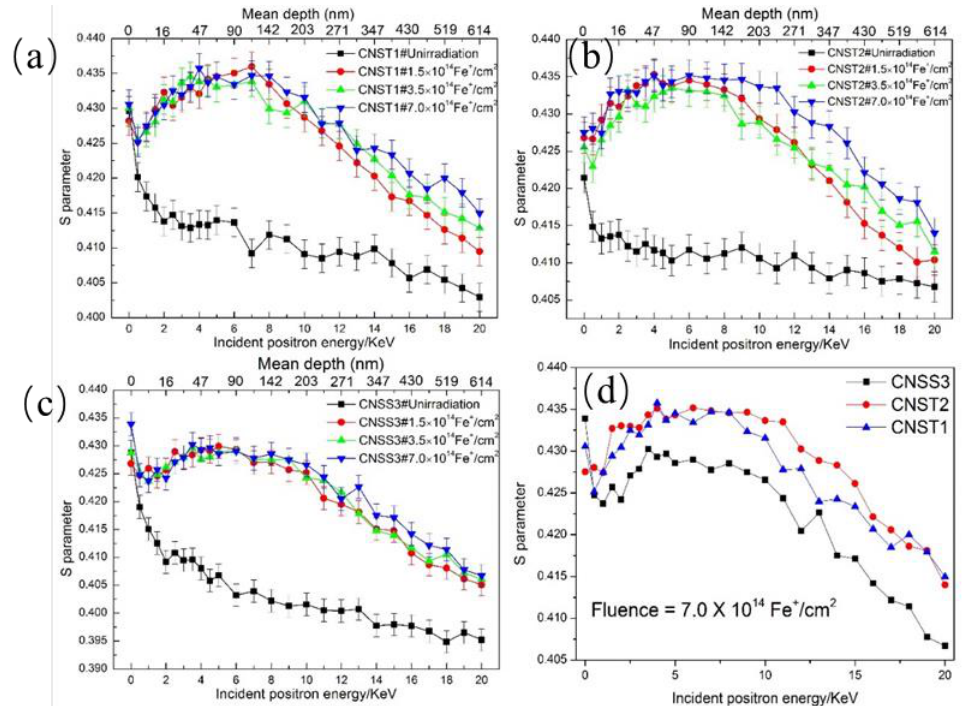
Figure 5. The relationship between S parameter and the positron energy, ( a ) CNST1 steel, ( b ) CNST2 steel and ( c ) CNSS3 steel, ( d ) These three types of steels irradiated with a fluence of 7.0 × 10 14 Fe + /cm 2 . The value of S parameter of the as-received samples decreases with increasing positron energy.